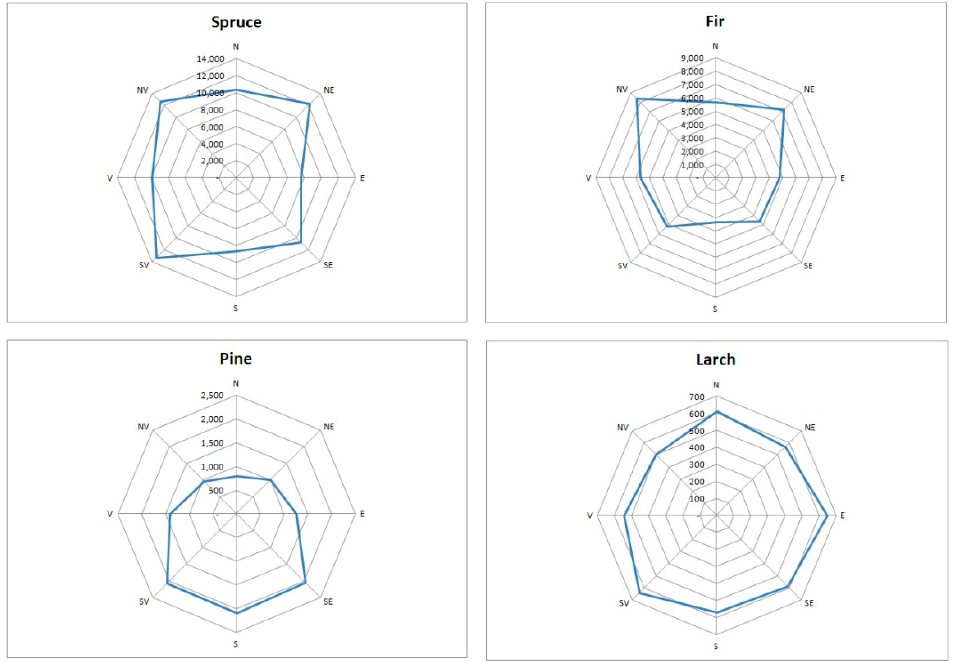
Figure 4. Distribution of stand elements based on field aspect for resinous species located in Southern Carpathians.